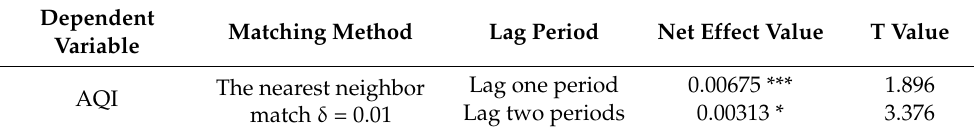
Table 4. Robustness test based on the lag period of policy implementation. Dependent Matching Method Lag Period Net Effect Value T Value Variable Lag one period 0.00675 *** The nearest neighbor AQI match δ = 0.01